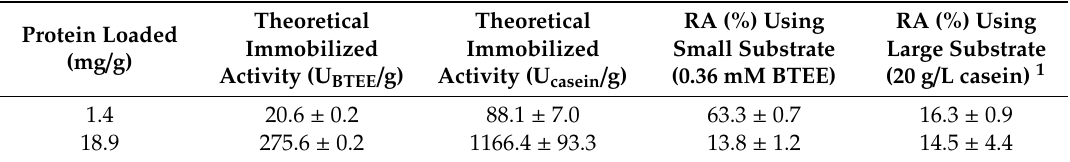
Table 1. Recovered activities (RA) of low- and high-loaded NPD derivatives (24 h reaction at 20 ◦ C and pH 10) measured with small (BTEE) and large (casein) substrates.